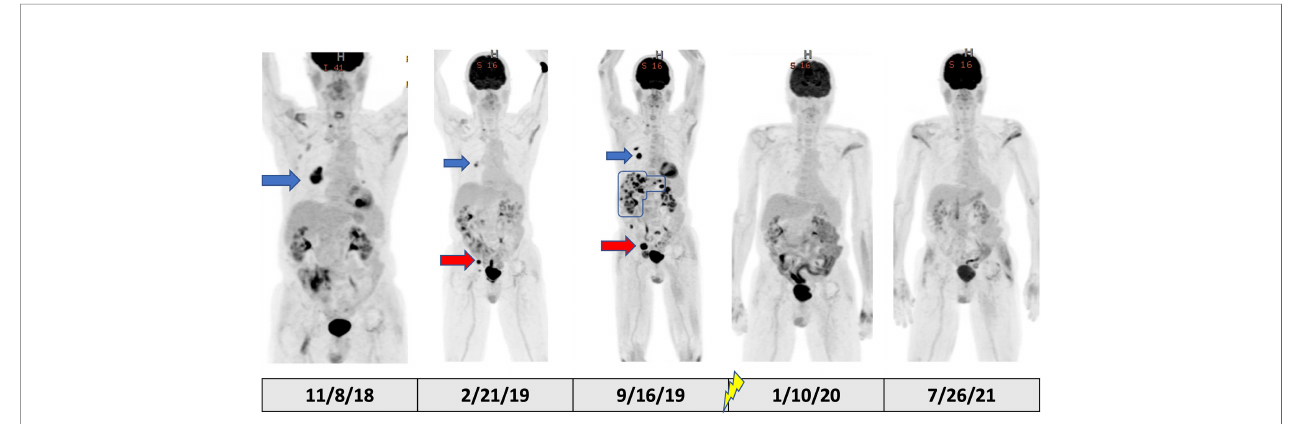
FIGURE 2 | PET/CT scout images over the course of the patient ’ s treatment. The blue arrows in the fi gure show the RLL nodule with good response to initial pembrolizumab monotherapy in February 2019 from the baseline scan in November 2018. However, the red arrows demonstrate a site of progression in the right pelvic sidewall through initial pembrolizumab monotherapy representing mixed response to initial pembrolizumab monotherapy. The September 2019 scan, after a break in pembrolizumab therapy for colitis, clearly shows progression of these lesions along with emergency of new, multifocal liver metastases (outlined with blue line). In October 2019, palliative RT was delivered to sacral metastatic lesion (signi fi ed by lightning symbol in the timeline). Subsequent PET/CT in January 2020 and July 2021 showed complete and durable response after completion of RT.